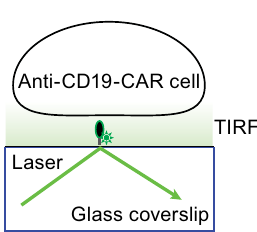
Figure 2. CAR-modi fi ed NK cell ISs on a glass-supported, planar lipid bilayer. (A) Schematic depiction of a TIRF setup in which a lipid bilayer contains a fl uorescence dye-labeled tumor antigen (green). TIRF (B), bright fi eld (C), and merge (D) images of CAR-modi fi ed NK cell IS formation on a glass-supported, planar lipid bilayer carrying an Alexa488-labled human CD19 protein (green). The three CAR-modi fi ed NK cells that con- tacted the lipid bilayer, as determined by the central accumu- lation of tumor antigen under TIRF microscopy, are numbered. Representative TIRF (E) and merge (F) images of CAR- modi fi ed NK cells are shown. Four individual CAR-modi fi ed NK cells, fi xed at 30 min after addition to the bilayer carrying CD19-Alexa Fluor 488, are numbered. The images are repre- sentative of at least 100 cells from three independent